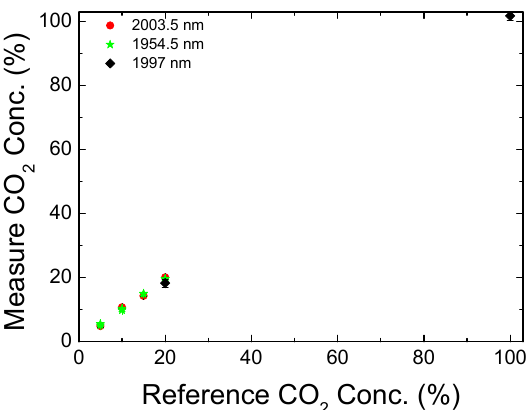
Figure 8. Final CO 2 concentration indicated by the sensor compared with nominal concentrations of the measured gas.